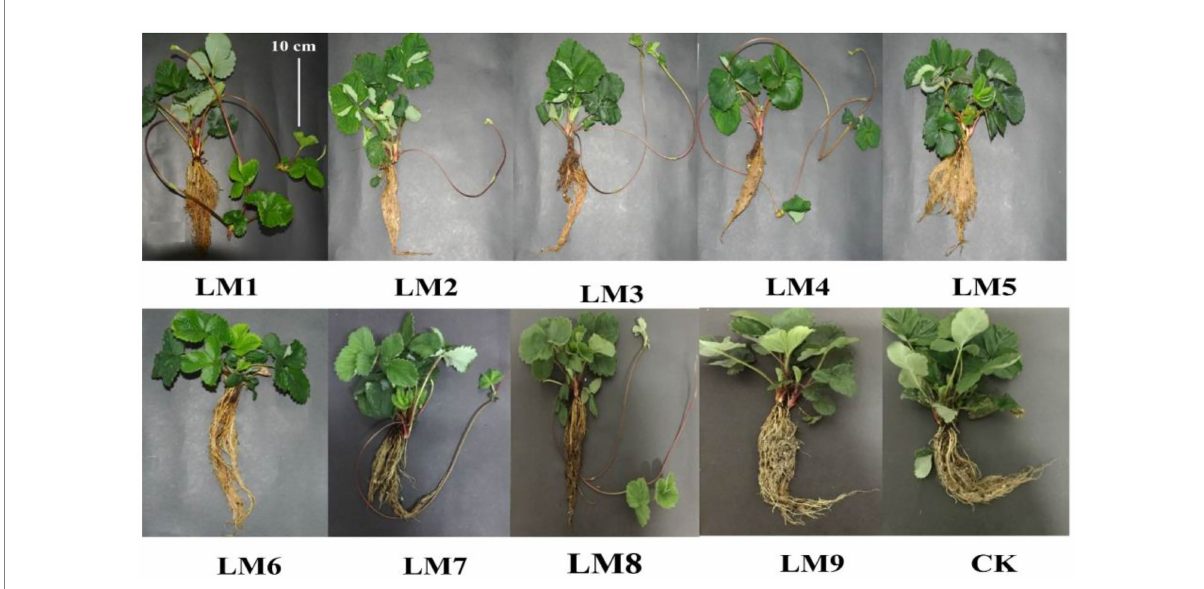
FIGURE 2 Effects of different lighting modes on the growth of strawberry plants after removing from the growing system measured after 53 days. For more details about the used light modes (LM), please refer to Table